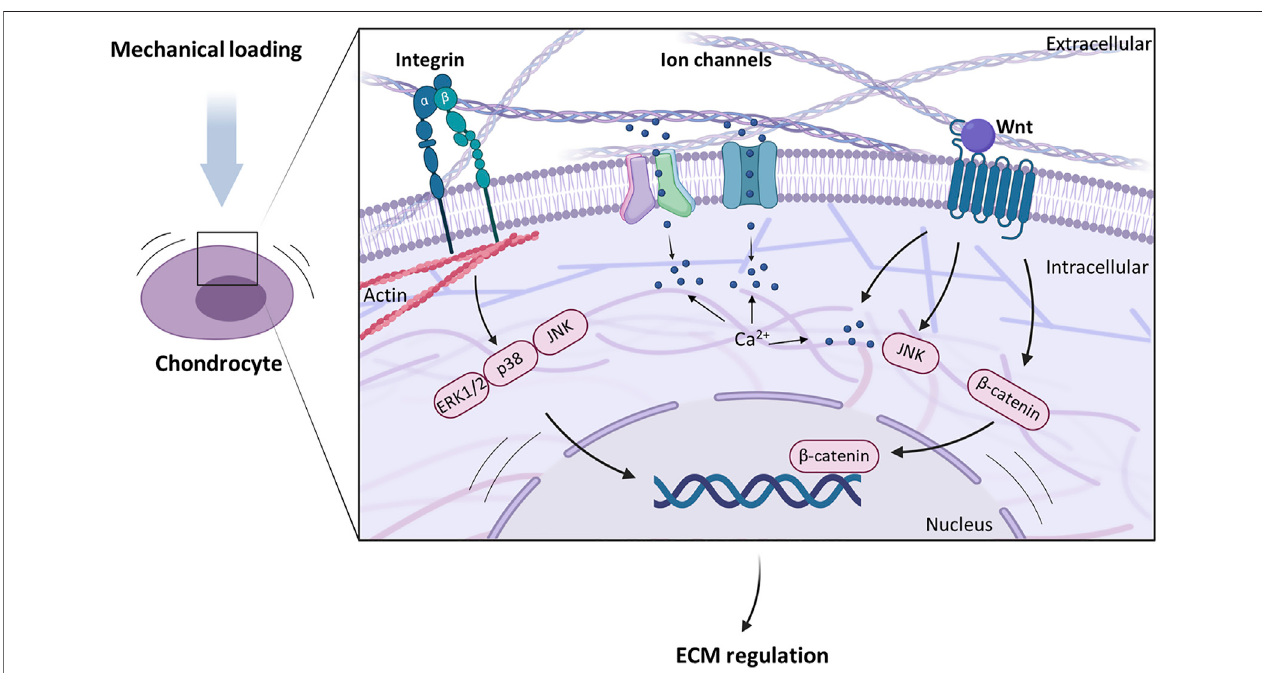
FIGURE 2 | Different cell membrane receptors and signalling molecules are involved in chondrocyte mechanotransduction. Transmembrane ion channels induce intracellular Ca 2+ signalling upon mechanical stimulation of cartilage and regulate extracellular matrix (ECM) biosynthesis. Integrins serve as a link between ECM molecules and the cytoskeleton and lead to an activation of the MAPK pathway. Signalling molecules such as Wnt activate intracellular signalling cascades that are important for cartilage homeostasis.